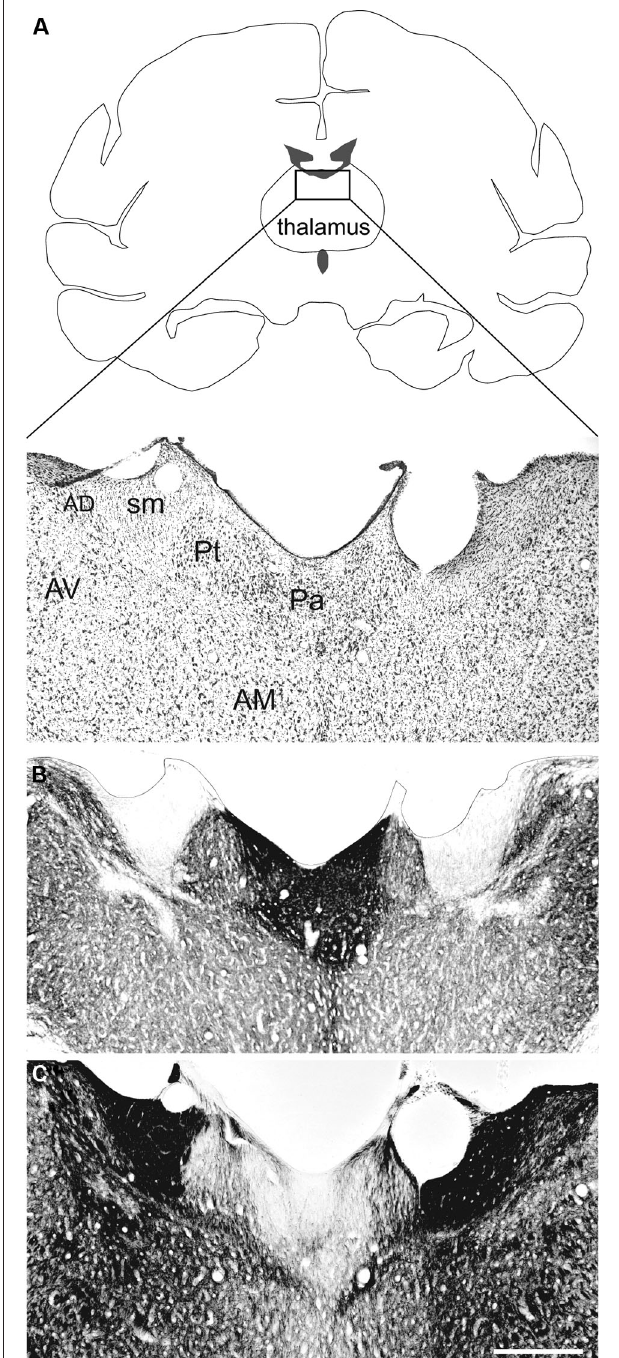
FIGURE 1 | The paraventricular nucleus of the thalamus (Pa) in nonhuman primates. The Pa is a small group of densely-packed neurons in the dorsal midline thalamus. Shown here are three adjacent coronal sections through the dorsal midline thalamus of the Macaca fascicularis stained for (A) Nissl, (B) AChE, and (C) myelin. The Pa is densely stained with AChE but is relatively lightly stained for myelin. Other thalamic nuclei shown are the anterodorsal (AD), anteromedial (AM), anteroventral (AV), and parataenial (Pt) nuclei. The stria medullaris (sm) is also shown. Scale bar = 500 µ m. Adapted from Hsu and Price